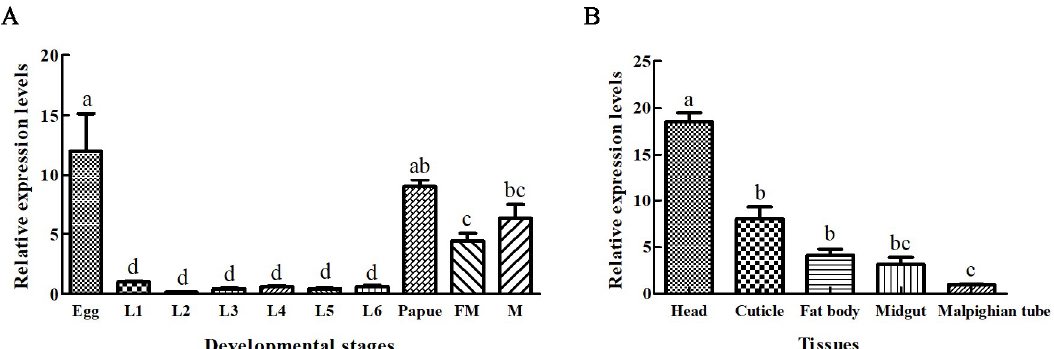
Figure 2. The transcript abundance of Sf-IBM1 in insects at different developmental stages and in tissues of sixth instar larvae. ( A ) The transcript abundance of Sf-IBM1 in insects at different developmental stages. L: larvae, FM: female, M: male; ( B ) The expression pattern of Sf-IBM1 in various tissues. Sf-GAPDH was used as the reference gene for qRT-PCR results normalization. Different letters above the bars show significant differences between different samples ( p < 0.05).